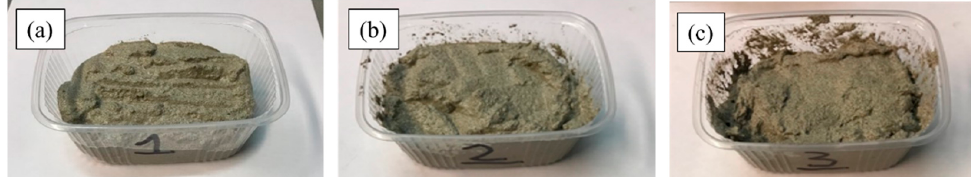
Figure 1. SEM image of cenospheres ( a ), histogram of cenosphere particles size distribution ( b ) and LM image of the polypropylene Belmix™ fibers ( c ).